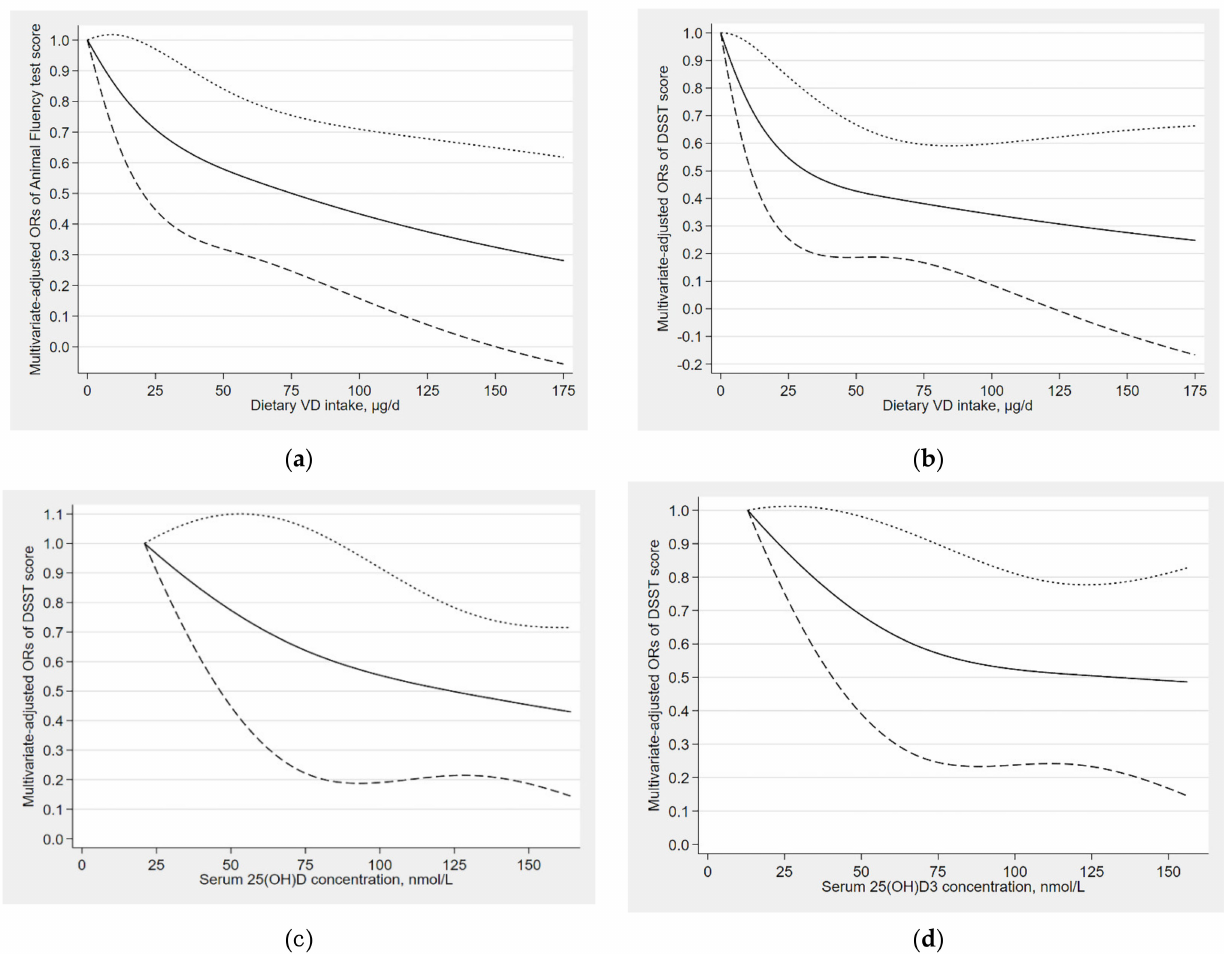
Figure 2. ( a ) Dose–response relationship between dietary VD intake and the risk of low cognitive performance (Animal Fluency test); ( b ) Dose–response relationship between dietary VD intake and the risk of low cognitive performance (DSST); ( c ) Dose–response relationship between serum total 25(OH)D concentration and the risk of low cognitive performance (DSST); ( d ) Dose–response relationship between serum 25(OH)D 3 concentration and the risk of low cognitive performance (DSST). The solid line represents the OR values and dashed lines represent the 95% confidence